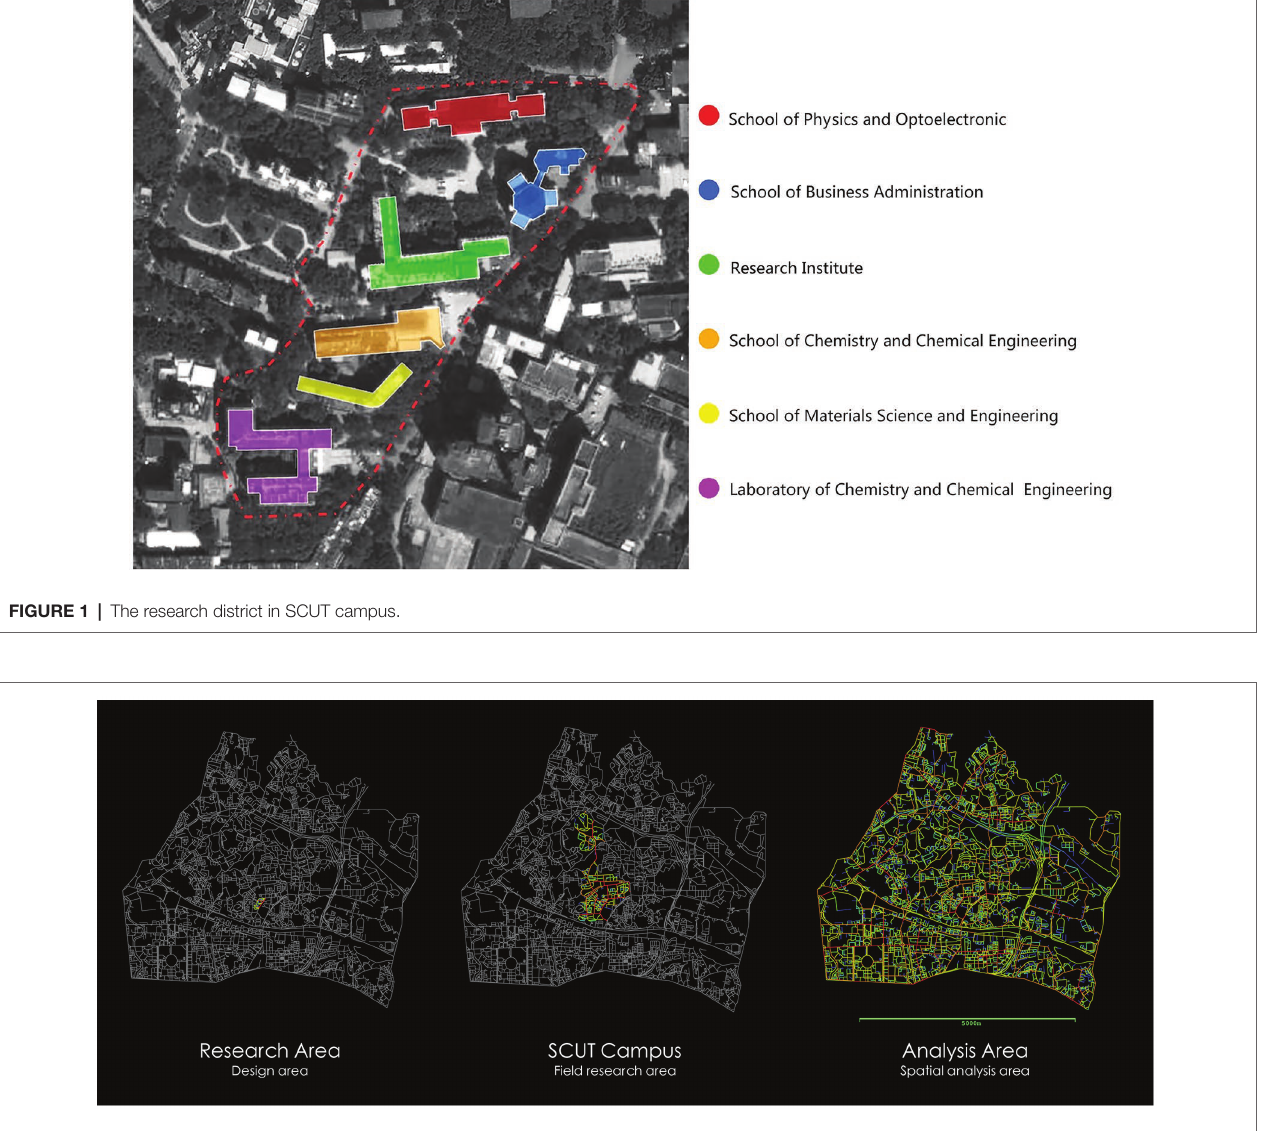
FIGURE 2 | The study